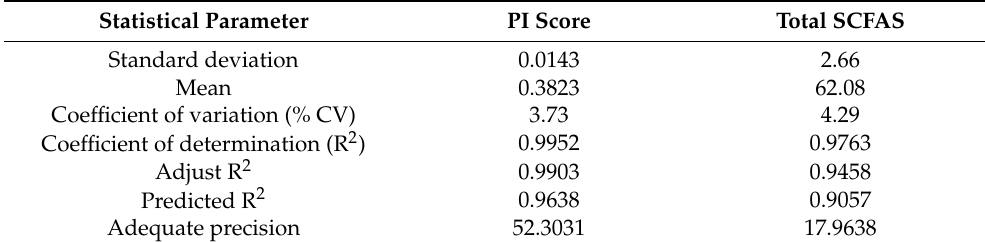
Table 5. Fit statistics of the PI score and total SCFAs with a Box–Behnken design (BBD)